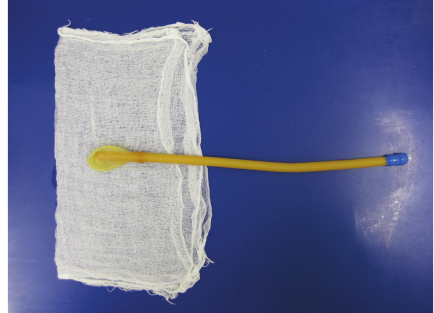
Figure 1: An intrauterine balloon catheter is positioned on the center of two sheets of gauze (30 × 30 cm) which is impregnated with 20 mL of 5% tranexamic acid solution (=1 gram of tranexamic acid) and folded in half.